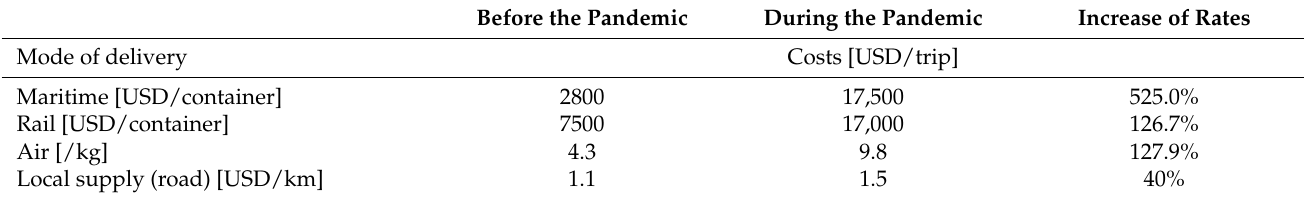
Table 2. Costs of